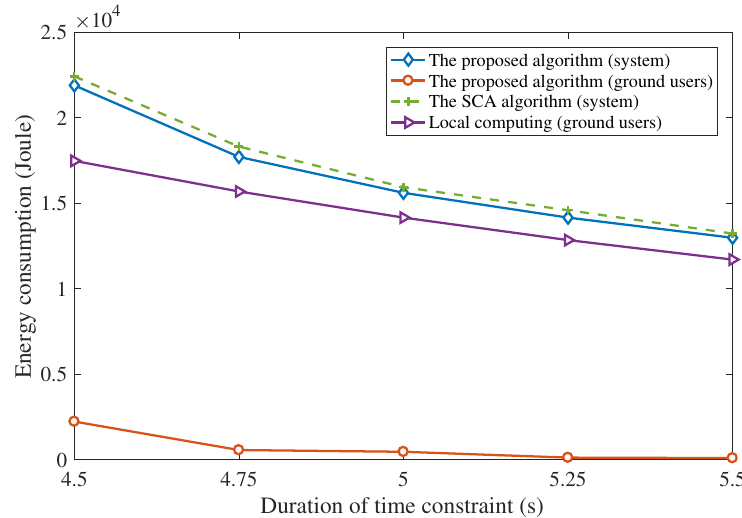
Figure 11. The total energy consumption of the MEC system under different time constraints ( I 1 = I 3 = I 5 = 2 × 10 7 bits, I 2 = I 4 = 8 × 10 7